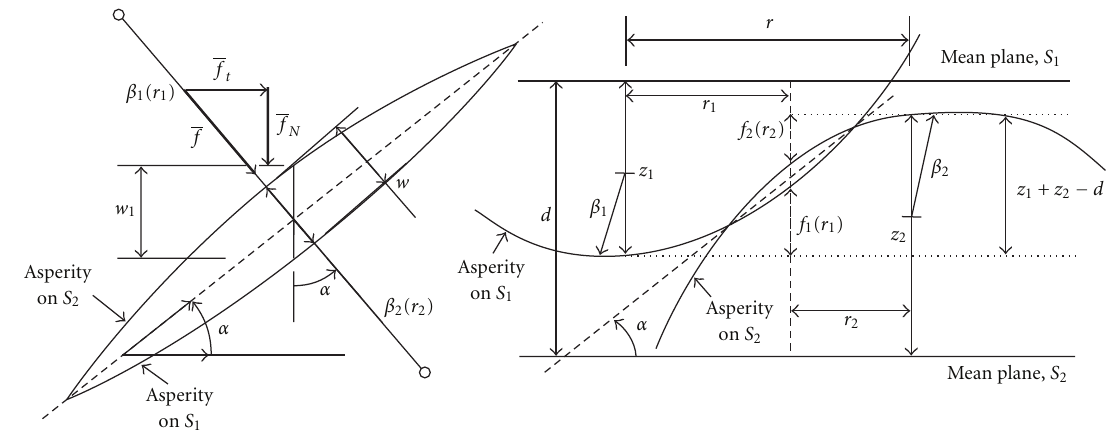
Figure 2: Asperity contact: Overlap region showing normal and oblique interferences-Elastic-plastic force and its components.